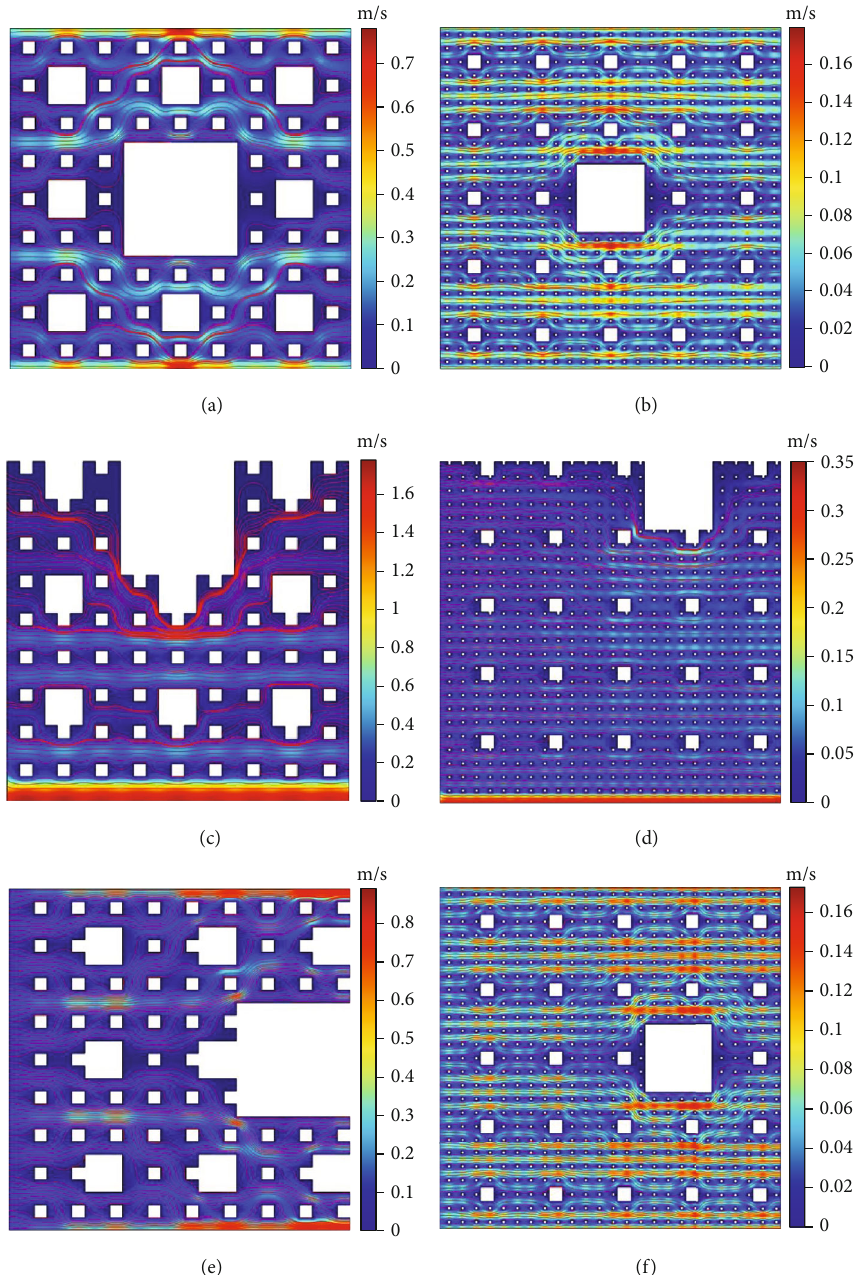
Figure 7: The velocity contour with streamlines for the 3rd order of anisotropic Sierpinski carpet models: (a) A1 (isotropic), (b) A3 (isotropic), (c) A1 ( ε x = 0 , ε y = 1 ), (d) A3 ( ε x = 1 , ε y = 2 ), (e) A1 ( ε x = 1 , ε y = 0 ), and (f) A3 ( ε x = 1 , ε y = 0